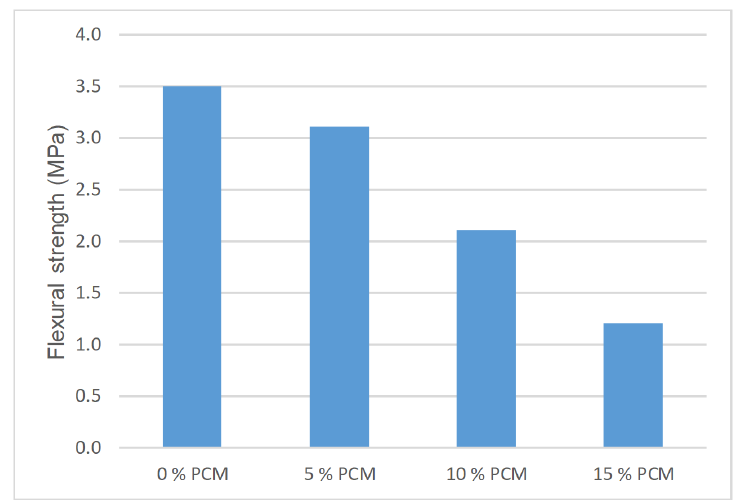
Figure 15. Flexural strength for PX27, CEM I 52.5 R and w/c = 1 mortar